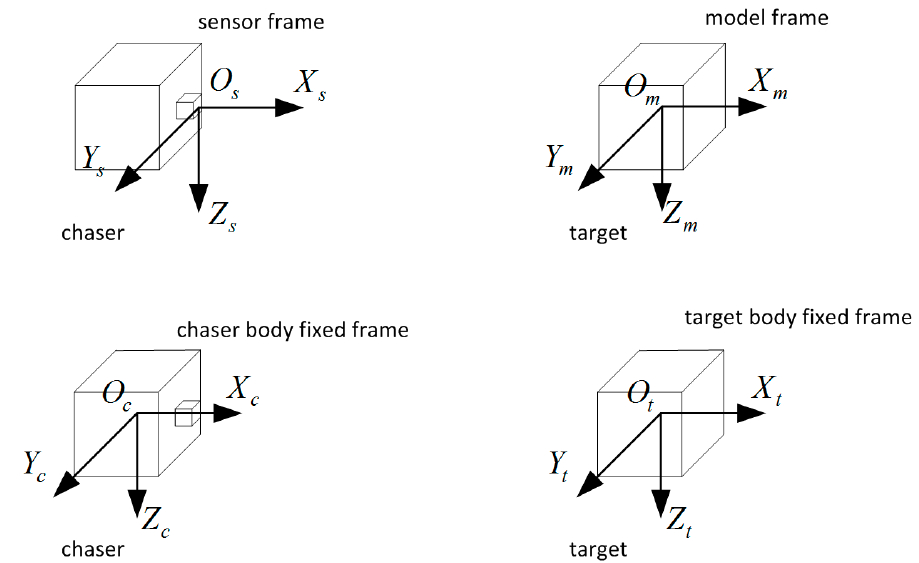
Figure 2. The definition of reference frames.